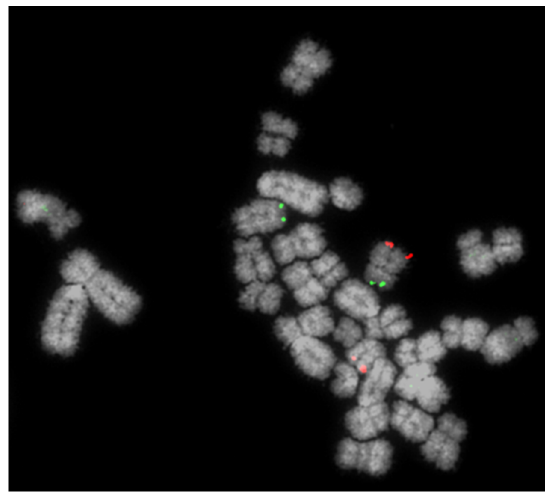
Figure 1 . Detection of a reciprocal translocation of chromosomes 4 and 5 using the Multiprobe fluorescence in situ hybridisation (FISH) approach. BACs (bacterial artificial chromosomes) for the short (p) arm (green) and long (q) arm of chromosome 4 are clearly visible on the same (normal) chromosome but on different chromosomes where the RT is involved.